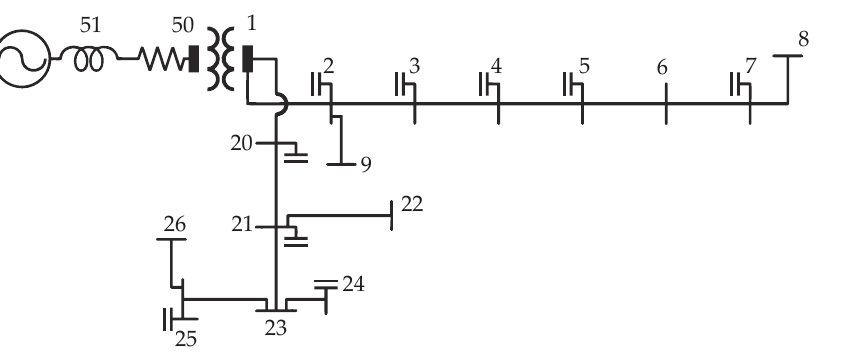
Figure 6. 18-bus test system.